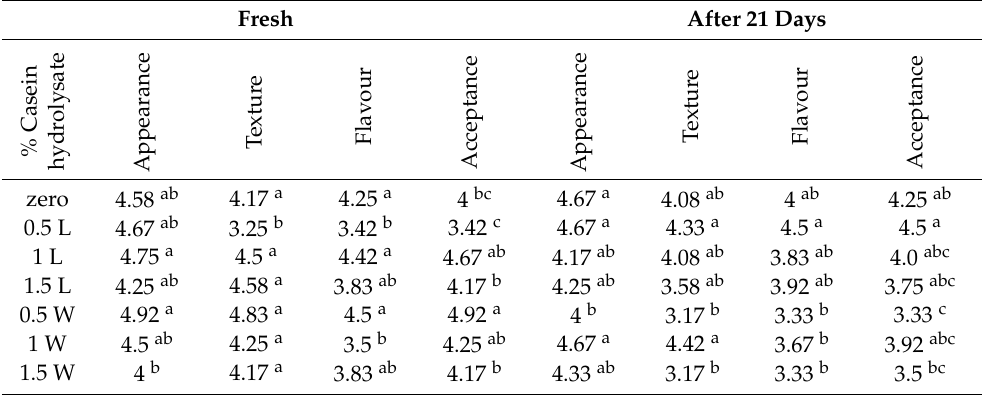
Table 3. Effect of milk casein hydrolysate addition on sensory evaluation of yoghurt. Fresh After 21